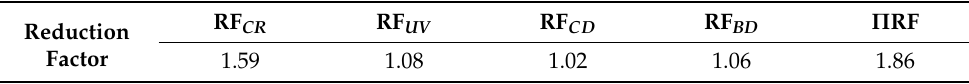
Table 8. Total reduction factor of LCP woven geotextile’s long-term performance model. Reduction